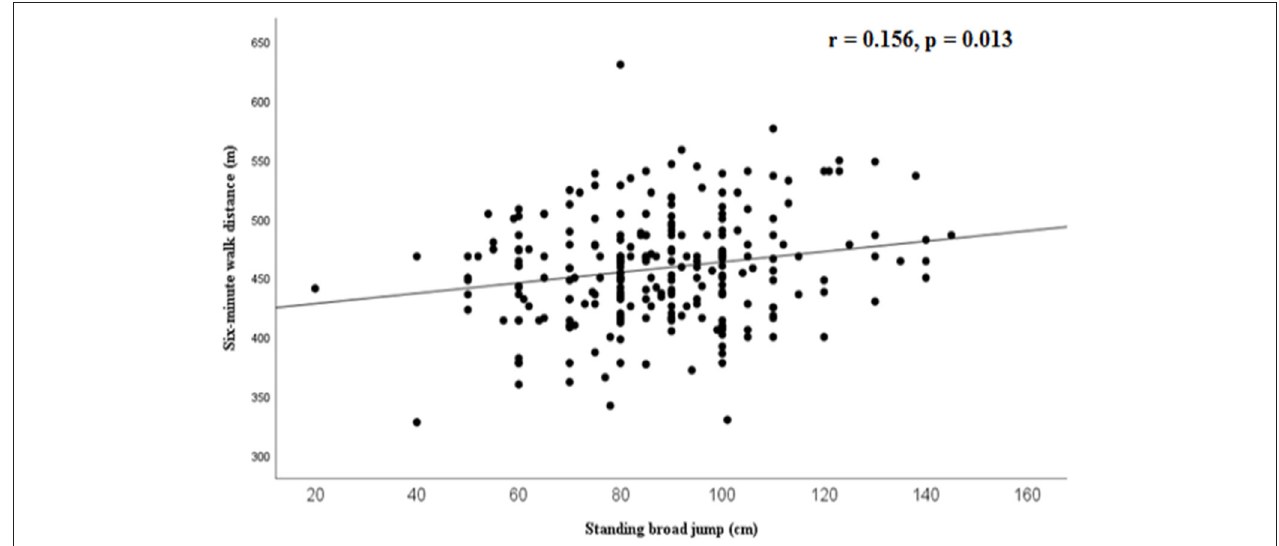
FIGURE 1 | Correlation between six-minute walk distance and standing broad jump.